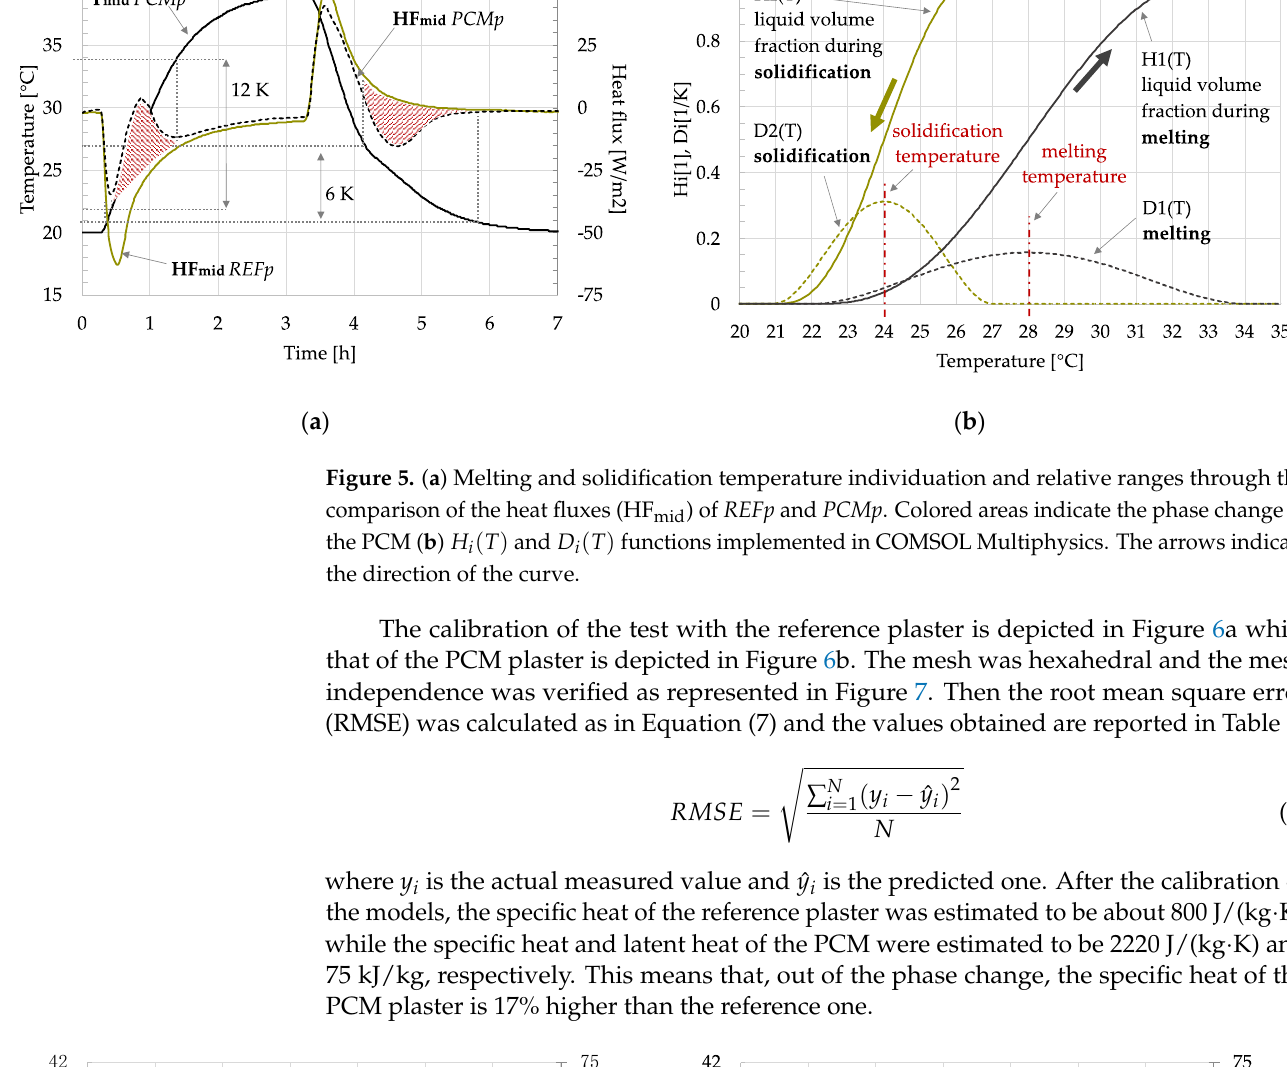
Table 6. RMSE calculated for both calibrations.